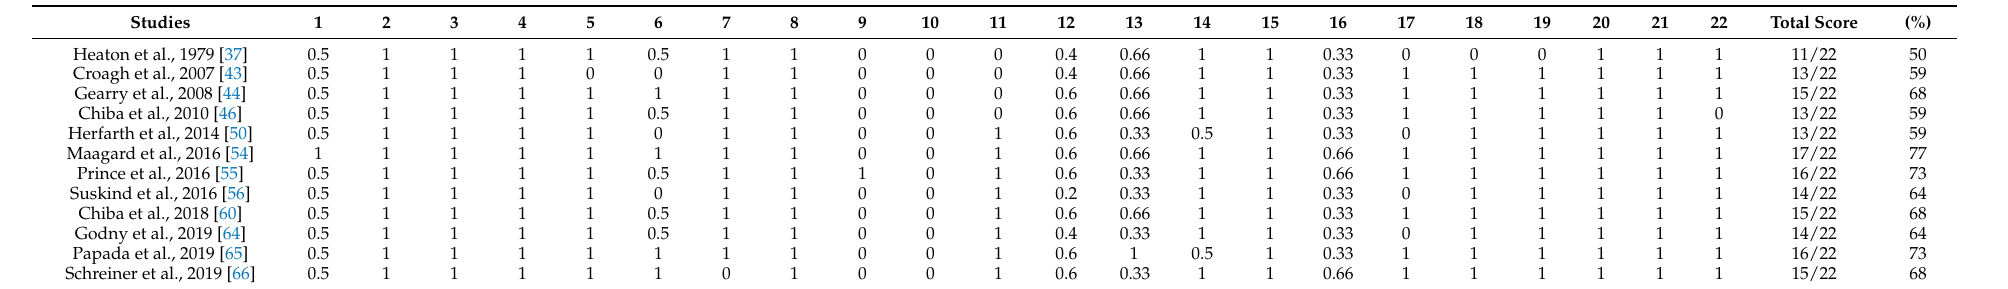
Table 4. Methodological quality analysis according to the STROBE (Strengthening the Reporting of Observational studies in Epidemiology) guide for reporting observational studies. Studies Heaton et al., 1979